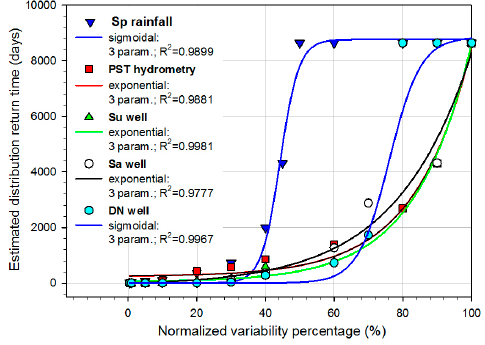
Figure 15. Estimated DRT vs. f i , j ( % )